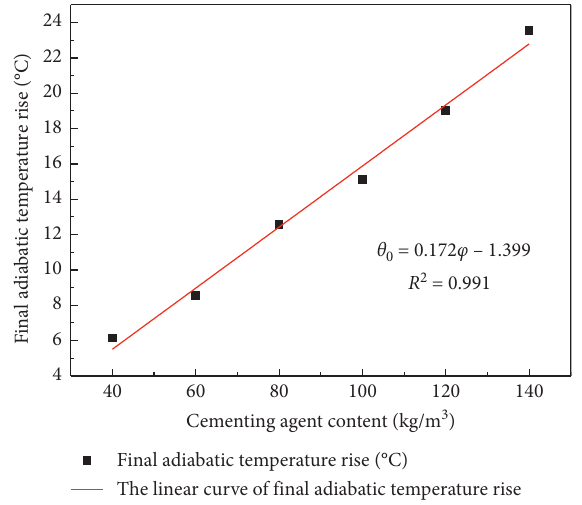
Figure 5: The relationship between cementing agent content and final adiabatic temperature